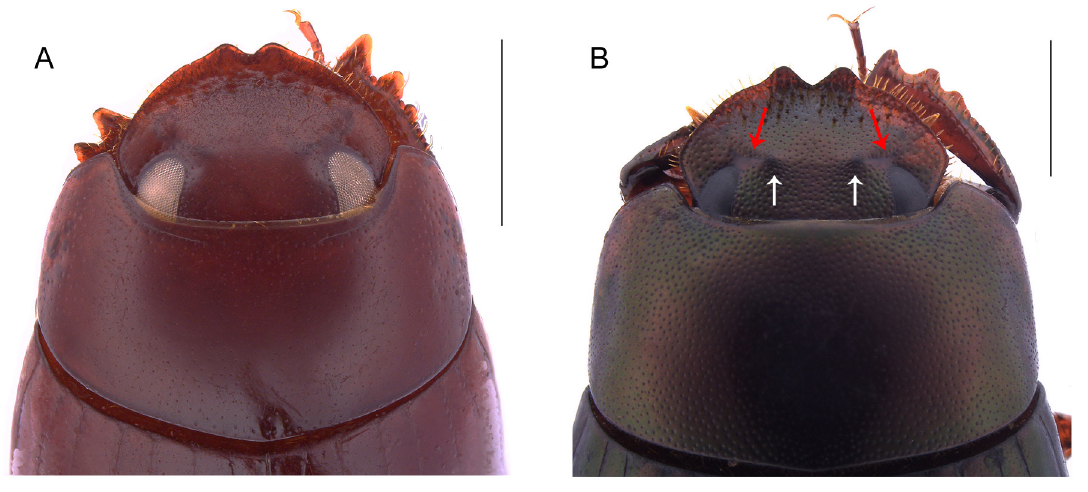
Fig. 5. Cephalic integument of species of Agamopus Bates, 1887. A . A. lampros Bates, 1887 (CEMT): smooth and lacking tubercles. B . A . joker sp. nov., holotype, ♂ (CEMT), with dense punctuation and two small tubercles. White arrows indicating the small cephalic tubercles. Red arrows indicating the lateral clypeal carina. Scale bars = 1